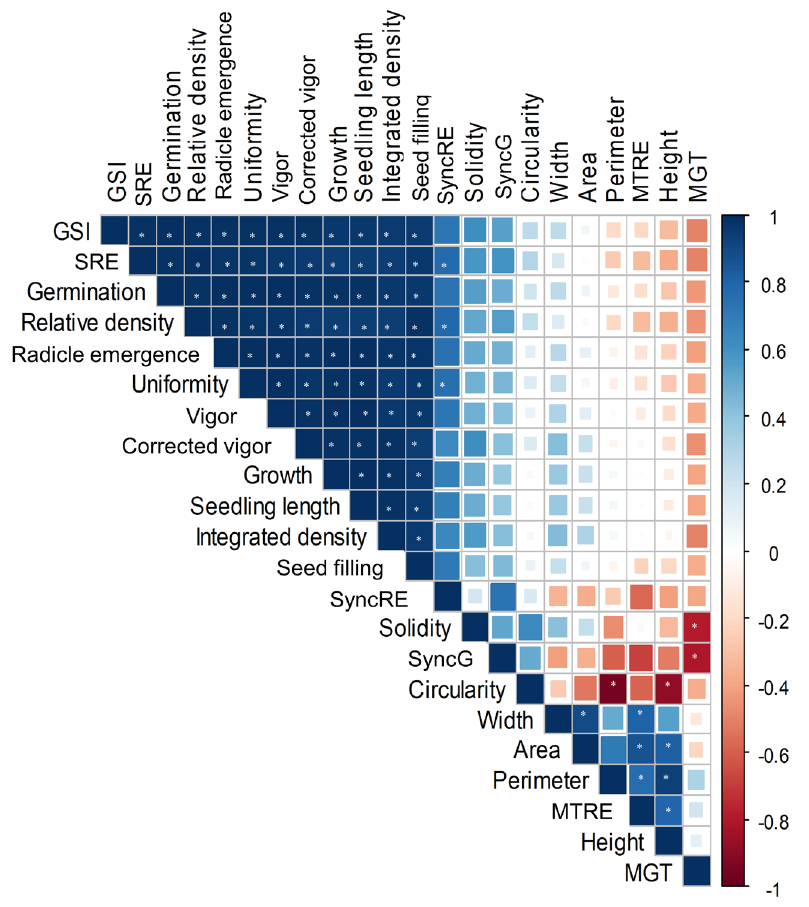
Figure 4. Correlation matrix obtained from physical and physiological data of seeds and characteristics of B rachiaria ruziziensis seedlings. * significant (p < 0.05) by the t test. SRE = Speed of radicle emergence, GSI = Germination speed index, MTRE = Mean time for radicle emergence, MGT = Mean germination time, SyncRE = Synchrony of radicle emergence, SyncG = Synchrony of